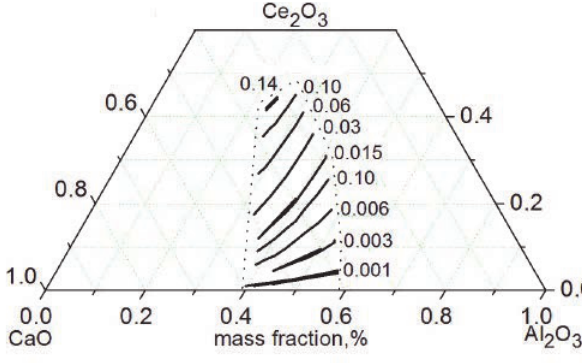
Fig. 4: The iso-mass action concentration curves of Ce 2 O 3 in CaO-Al O -Ce O ternary slag system at 1773 K 2 3 2 3